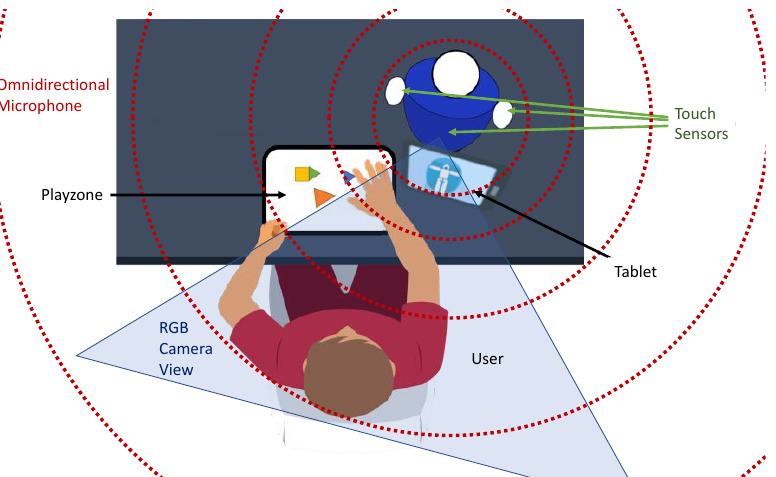
Figure 5. An illustration of the environmental setup of the case studies. We used the same colour coding as that in the 3D representation of the environment (blue for the camera, green for the touch sensors and red for the